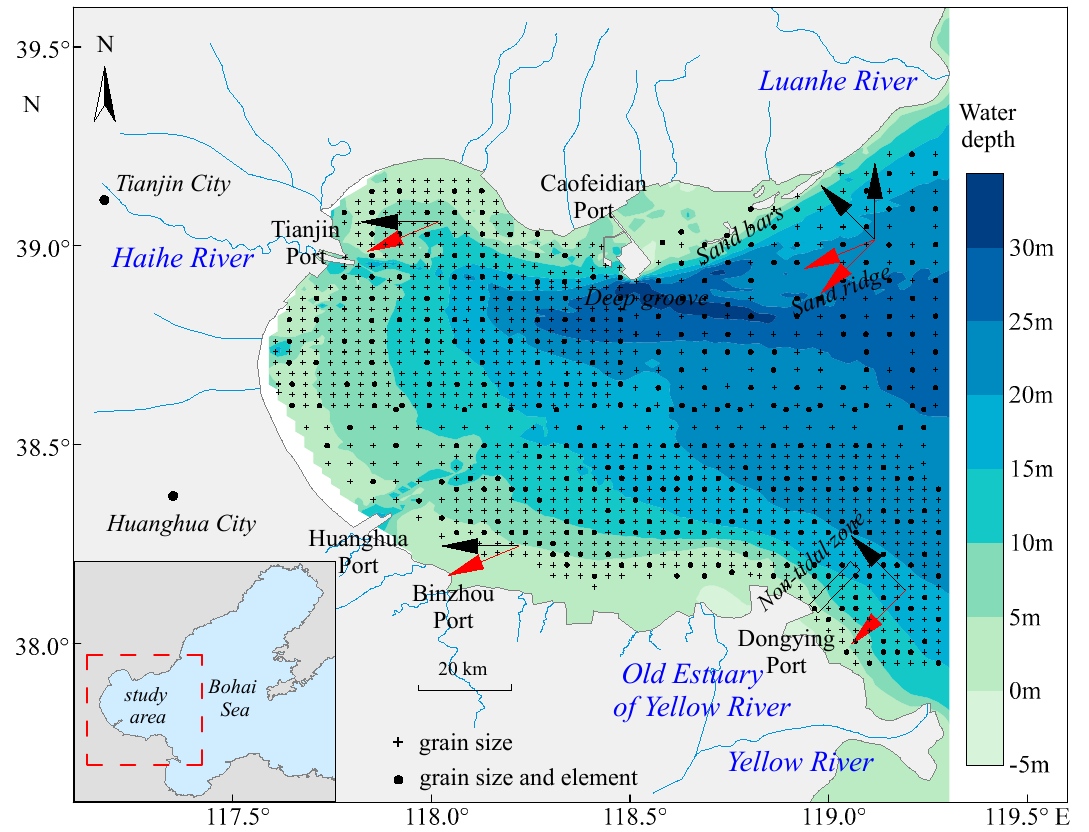
Figure 1. Location, circulation structure and wave direction of Bohai Bay and distribution of sam- pling sites. Black arrows indicate prevailing wave direction, and red arrows indicate strongest wave direction.